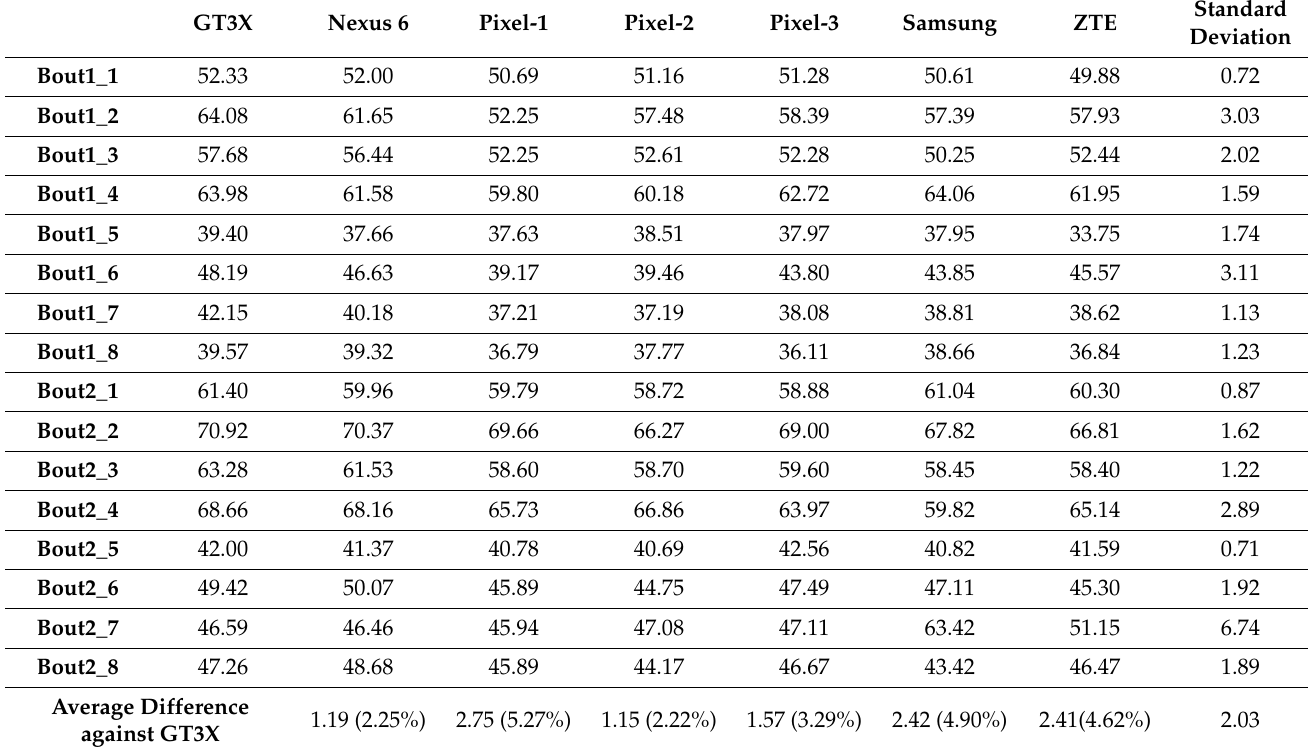
Table 4. Results for the second experimental series (unit: s).